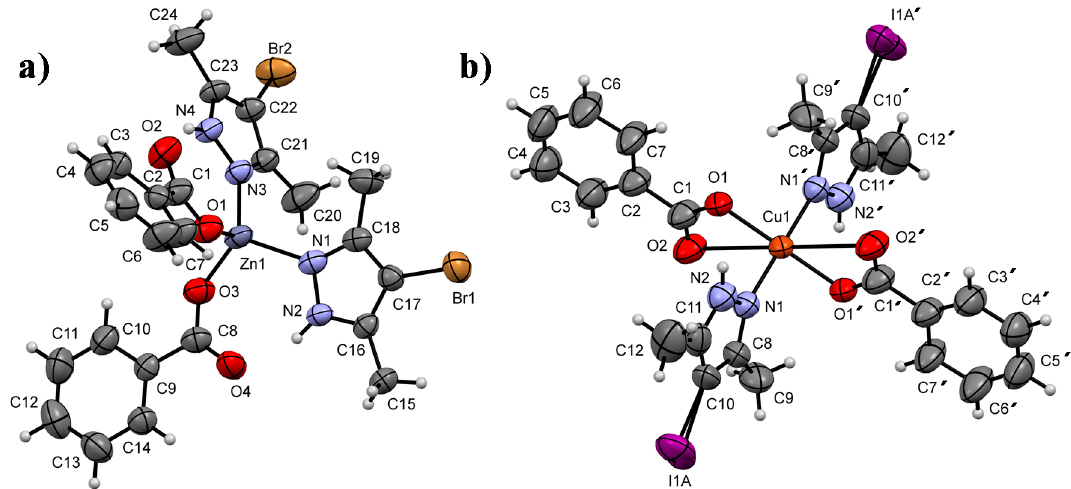
Figure 3. ORTEP plots of compounds ( a ) 1 and ( b ) 4 , showing displacement ellipsoids drawn at the 50% probability level. H atoms are shown as small gray spheres of arbitrary radii. Selected bond